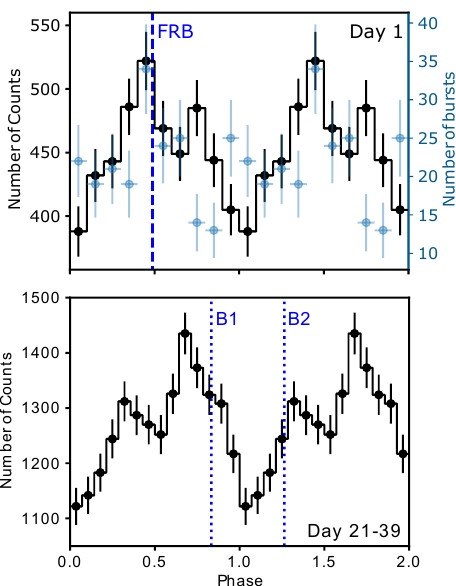
Figure 8. ( Top ): average pulse profile of SGR J1935 measured with NICER in the 1.5–5 keV energy band during the first day following FRB 20200428A (black points) along with the peaks of the bursts folded at the spin period (light blue). The phase of FRB 20200428A is shown with the vertical dashed line. ( Bottom ): same average pulse profile in the time interval from 21 to 39 days post FRB. The blue vertical lines show the relative phase of the two radio bursts observed by Kirsten et al. (2020) [225] (reproduced with permission from Younes, G. A., et al.; published by IOP Publishing, 2020